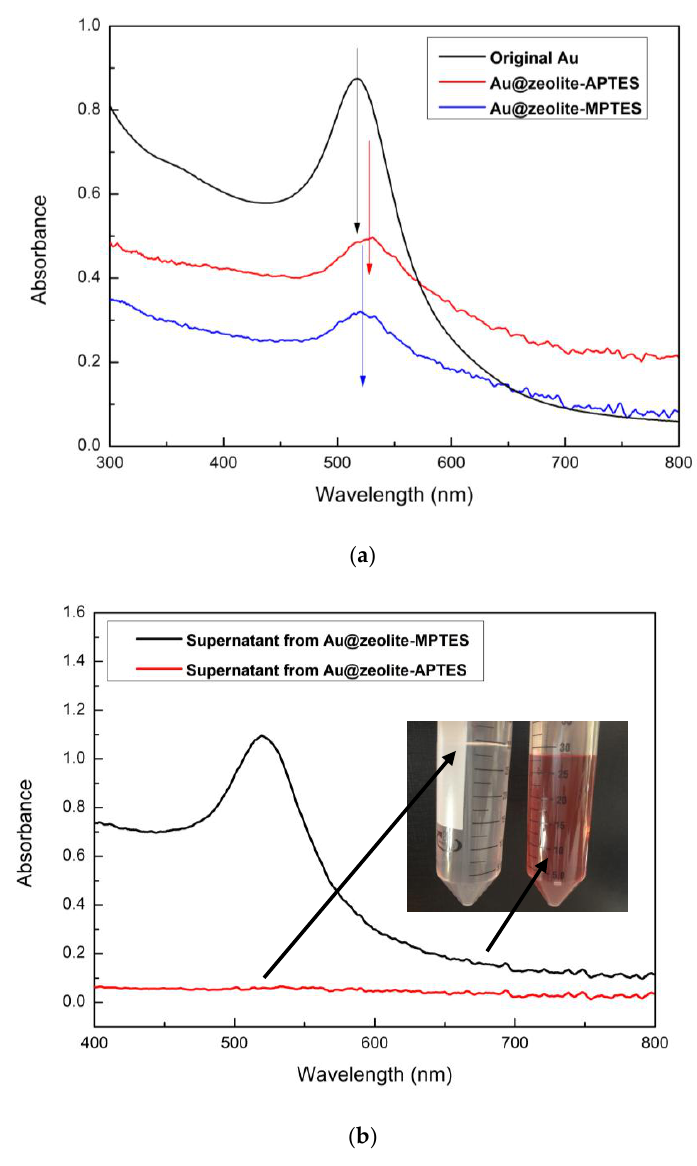
Figure 2. UV-Vis spectra of samples: ( a ) AuNPs immobilized zeolite; ( b ) supernatants collected after